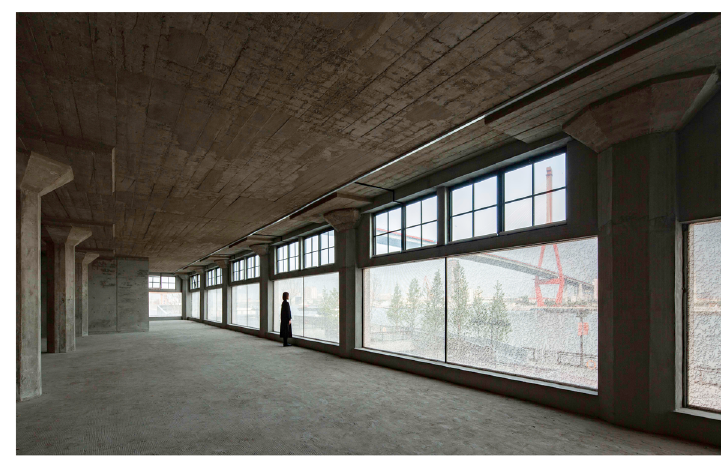
Fig. 8 Renovated beam and slab structures on the top level (Source: Tianzhou Yang)